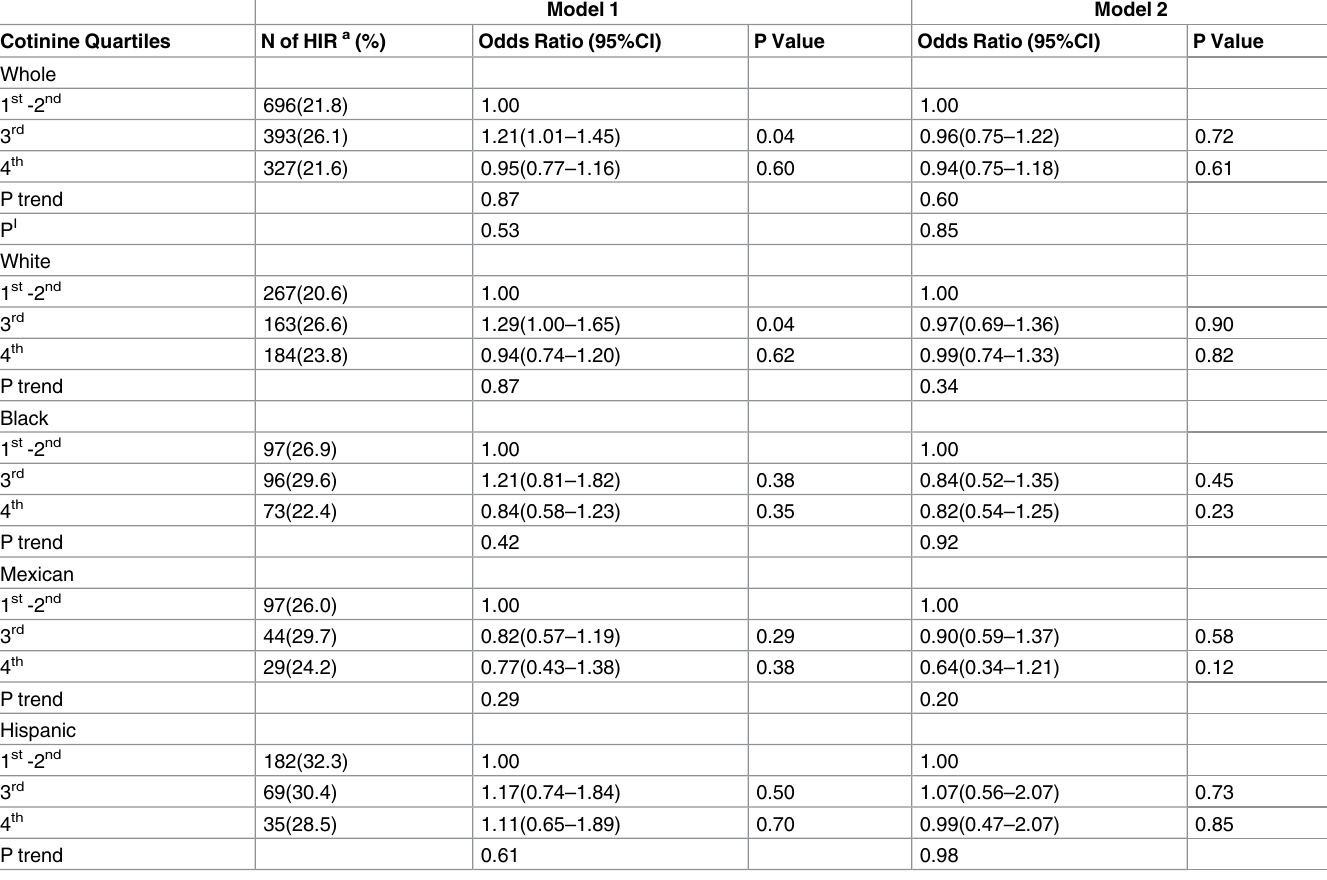
Table 2. Associations of quartiles of cotinine with HOMA-IR by